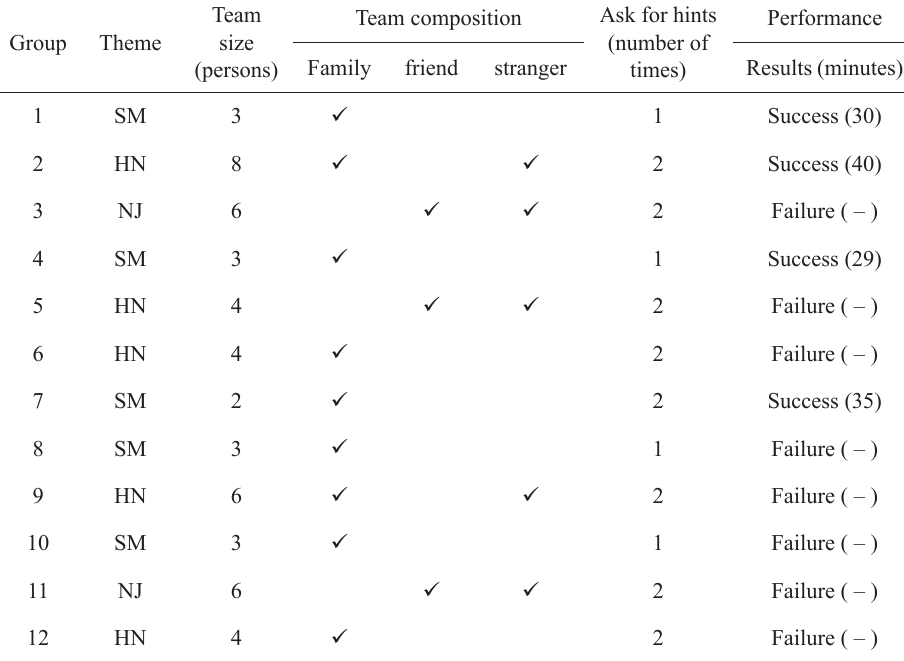
Table 2. Group profiles of real-life room escape game